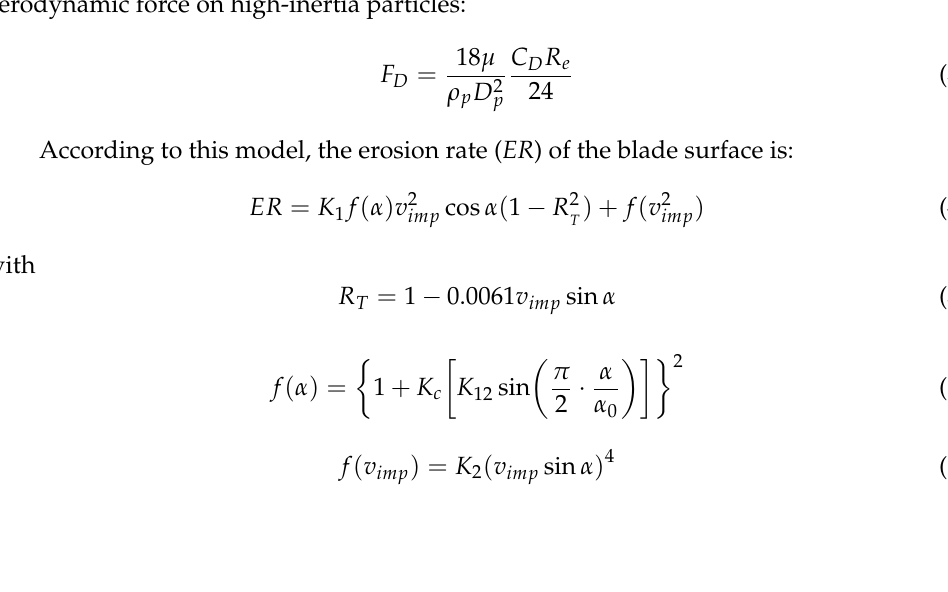
Figure 10. Flow near the leading edge of a ( a ) clean blade and ( b) coated blade. Reproduced from [55].